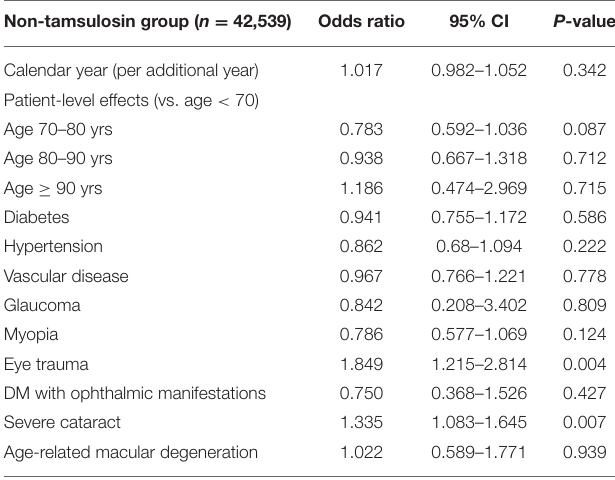
TABLE 4 | Effects of Calendar Year and Covariates on complication event of cataract surgery in the non-tamsulosin